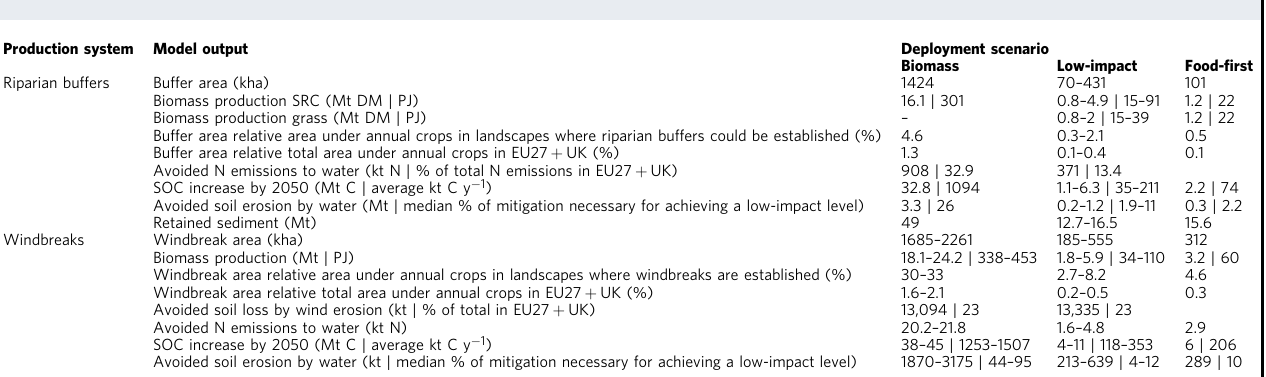
Fig. 1 Strategic deployment of riparian buffers. Share of maximum narrow buffer area needed to achieve a low level of nitrogen emissions to water ( a ), and the type of riparian buffers established in the three deployment scenarios ( b – d ). See “ Methods ” for information about what determines the buffer type in each landscape and scenario. Table 2 Model output for riparian buffers and windbreaks for the three deployment scenarios All values aggregated to EU27 +